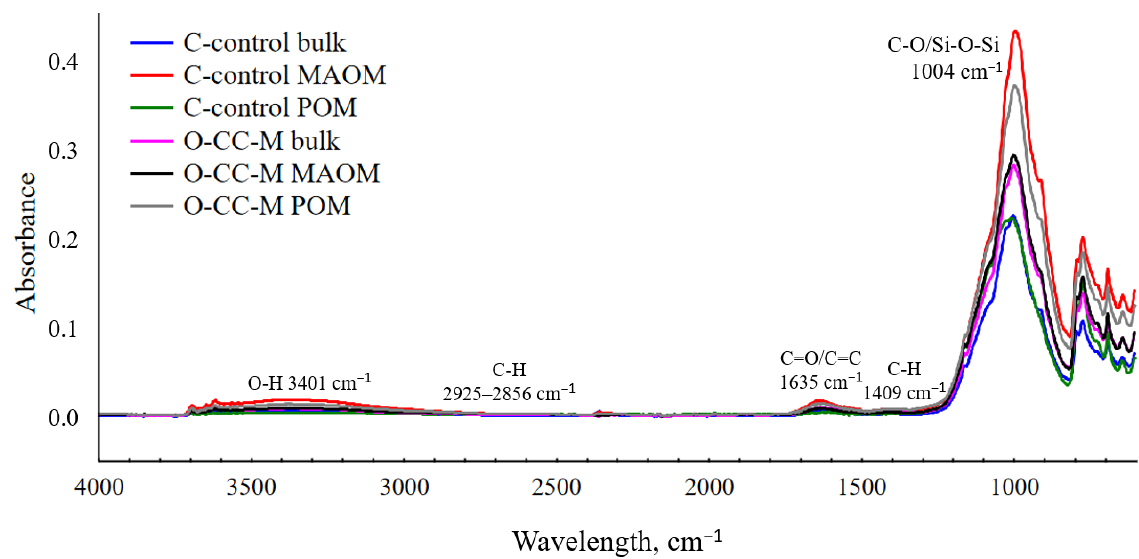
Figure 3. Sample FTIR spectra of the bulk soil and particulate organic matter (POM) and mineral-associated organic matter (MAOM) fractions of the C-control and O-CC-M treatments.